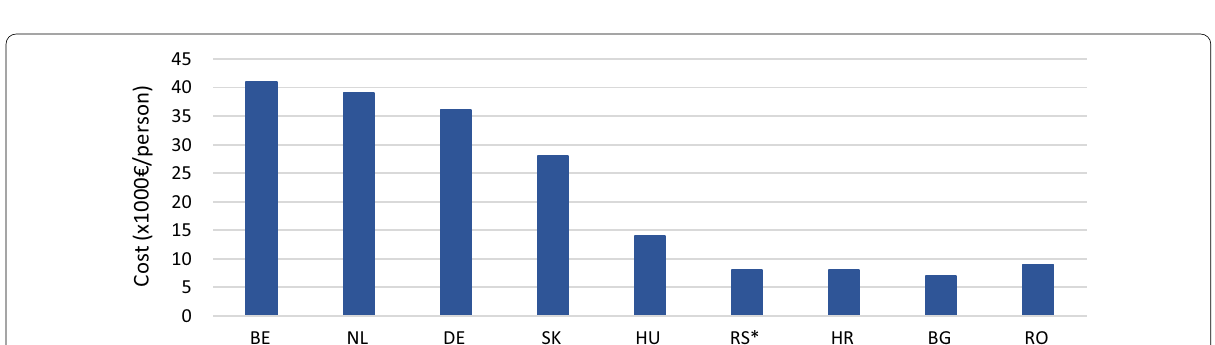
Fig. 1 Map of the Rhine and Danube corridors